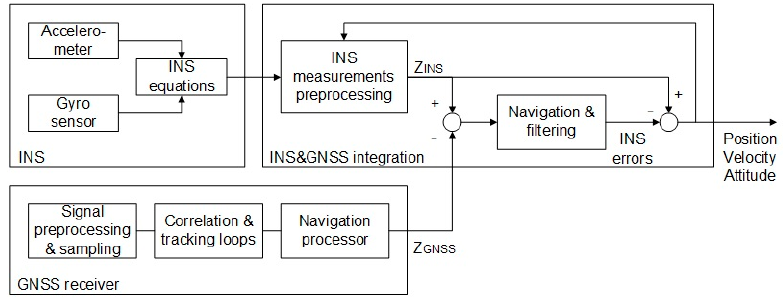
Figure 1. INS/GNSS loosely coupled integration scheme.